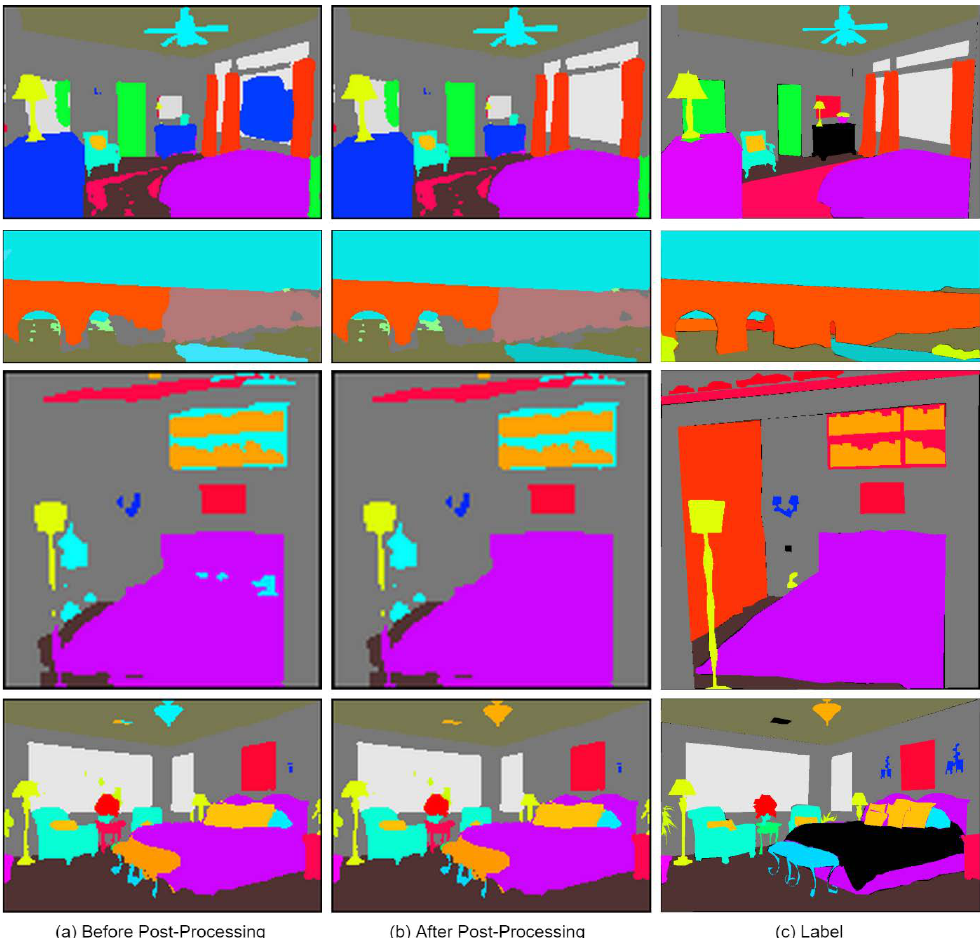
Figure 3. Examples of comparison before and after the post-processing